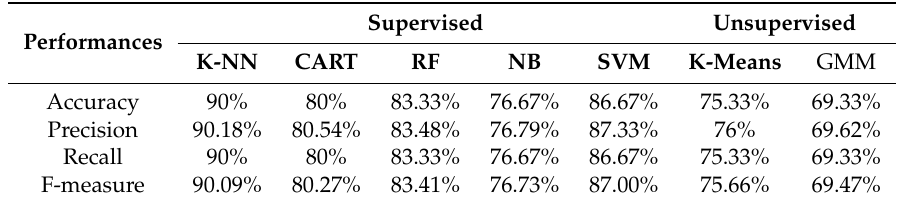
Table 15. Accuracy, Precision, Recall and F-measure for each classifier, obtained from the binary classification between PD and ALL (ALS, HD, and Healthy)